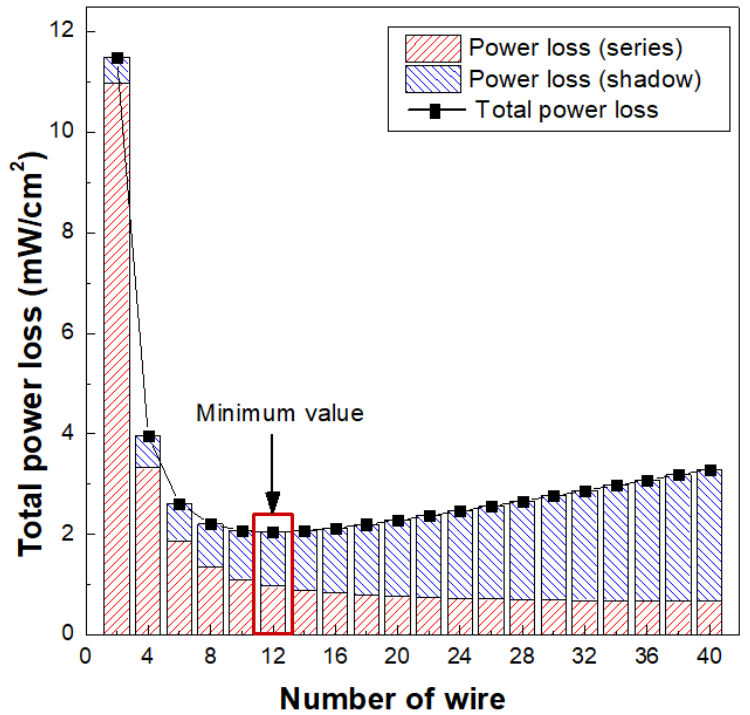
Figure 7. The ratio of shading and resistance losses with respect to the number of wires.